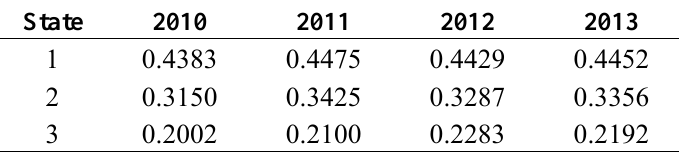
Table 6. Prediction state vectors for 2010 to 2013.